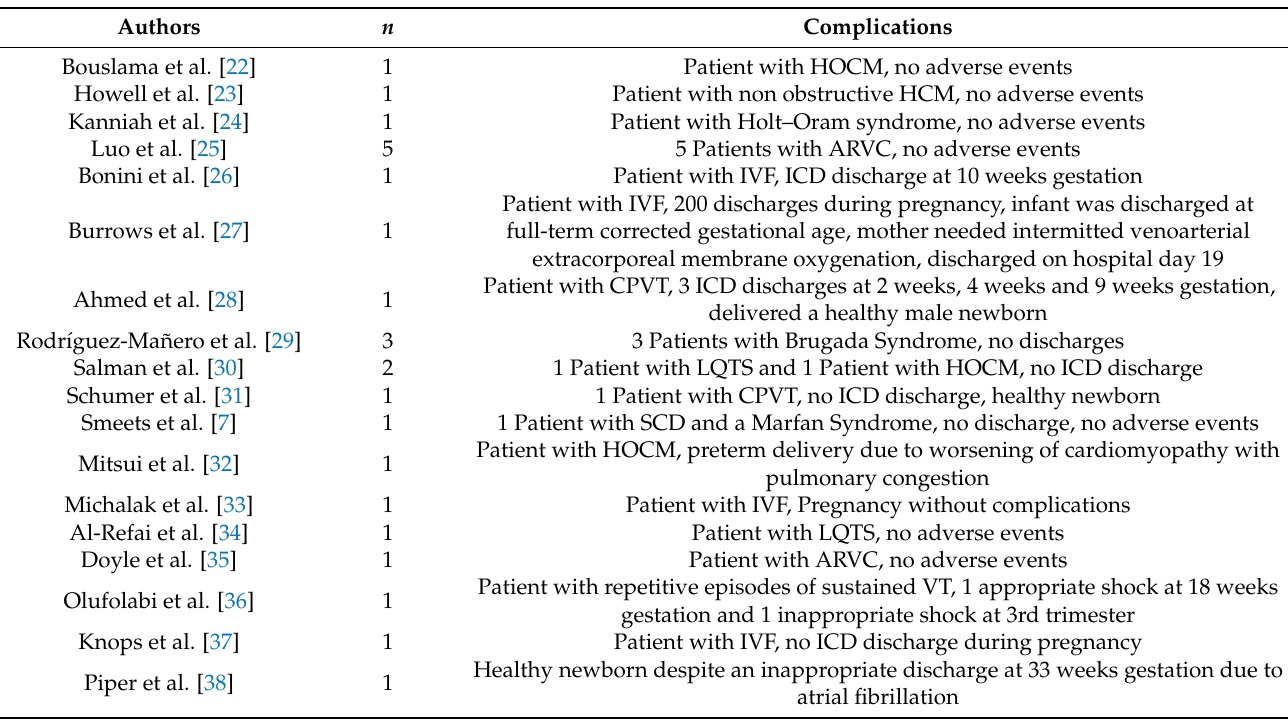
Table 2. Summary of the case reports and case series, including the authors’ names, the number of patients presented ( n ) and the most important